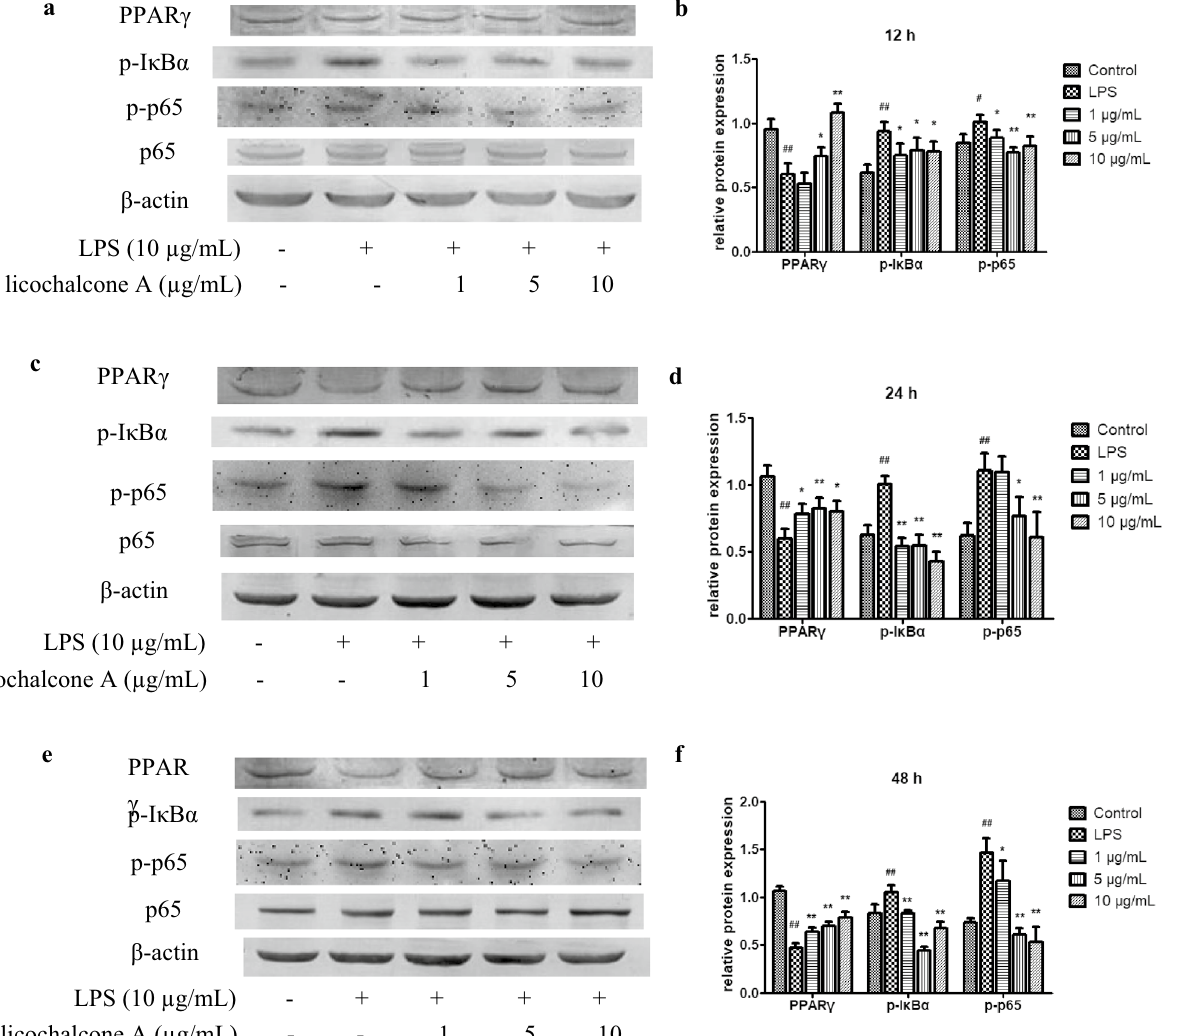
Figure 6. Effect of licochalcone A on LPS-induced protein levels of peroxisome proliferator-activated receptor γ (PPARγ), p-κB inhibitor α (IκBα) and p-p65 in claw dermal cells after treatment for 12 h ( a , b ), 24 h ( c , d ) and 48 h ( e , f ). Cells were exposed to gradient concentrations of licochalcone A (1, 5, 10 μg/mL) with or without the presence of 10 μg/mL LPS for 12, 24, and 48 h, respectively. The relative protein expressions of PPARγ/β-actin, p-IκBα/β-actin and p-p65/p65 were measured. The data were presented as mean ± SEM (n = 6). ## P < 0.01 vs. control group; # P < 0.05 vs. control group; * P < 0.05 vs. LPS model group; ** P < 0.01 vs. LPS model group (images are cropped. The full-length blots are presented in Supplementary